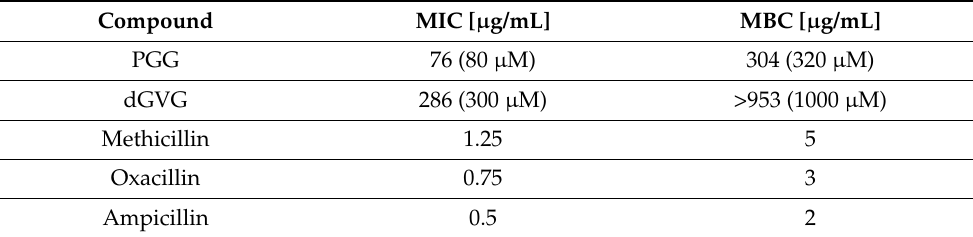
Table 1. Antibacterial activity (MIC and MBC) of PGG, dGVG, and β -lactam antibiotics against S. aureus 8325-4.